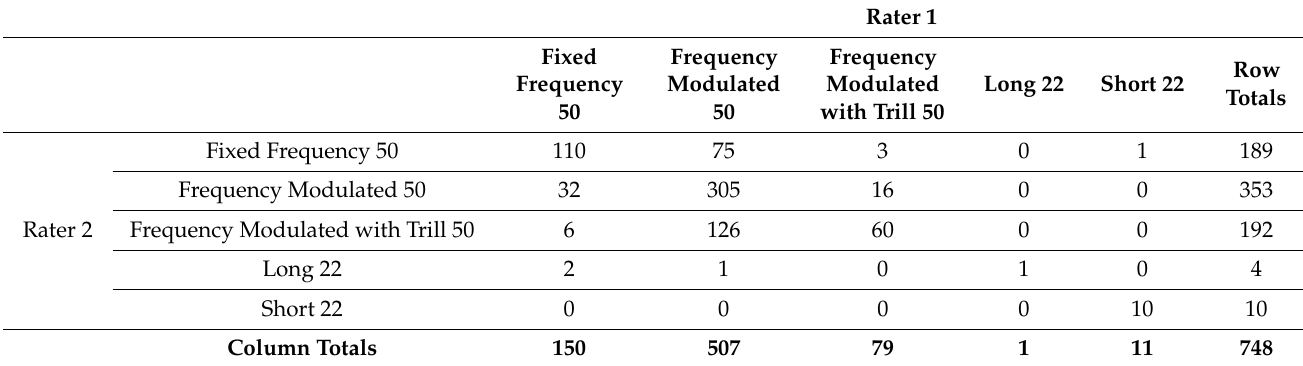
Table A1. Example of a confusion matrix comparing call types between two raters.